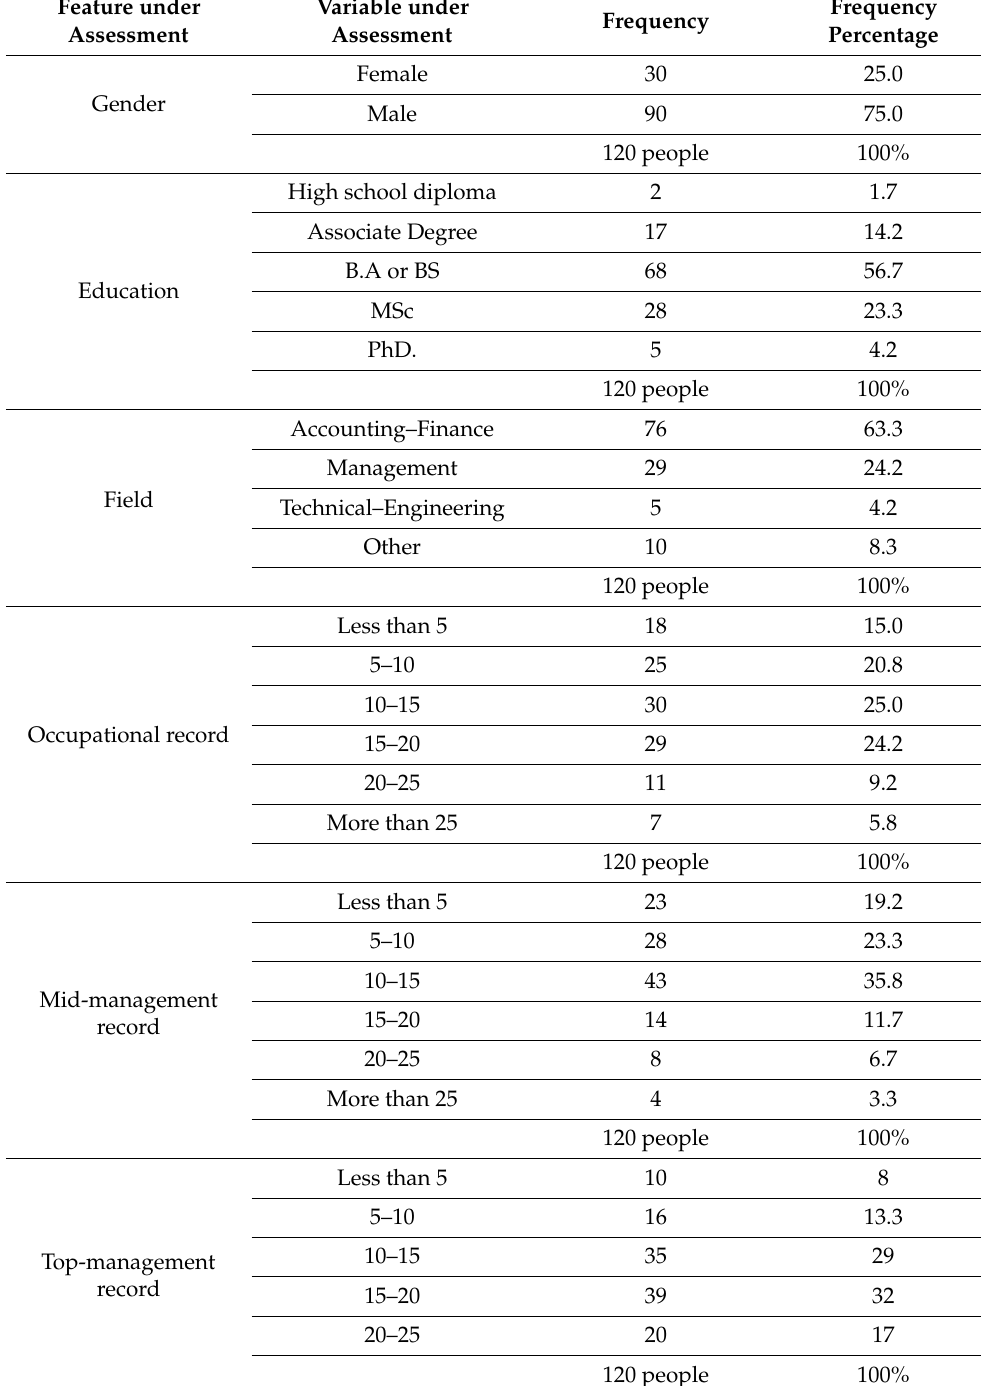
Table 2. The total frequency and percentage of data. Feature under